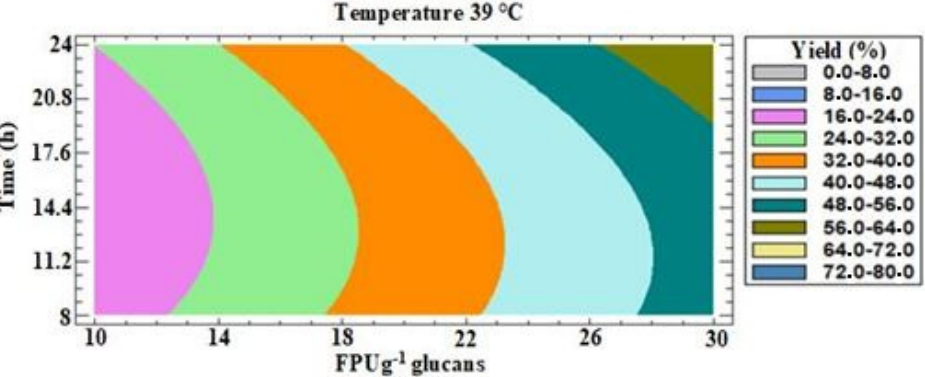
Figure 2. Contours of the estimated response surface of Model I (39 °C).